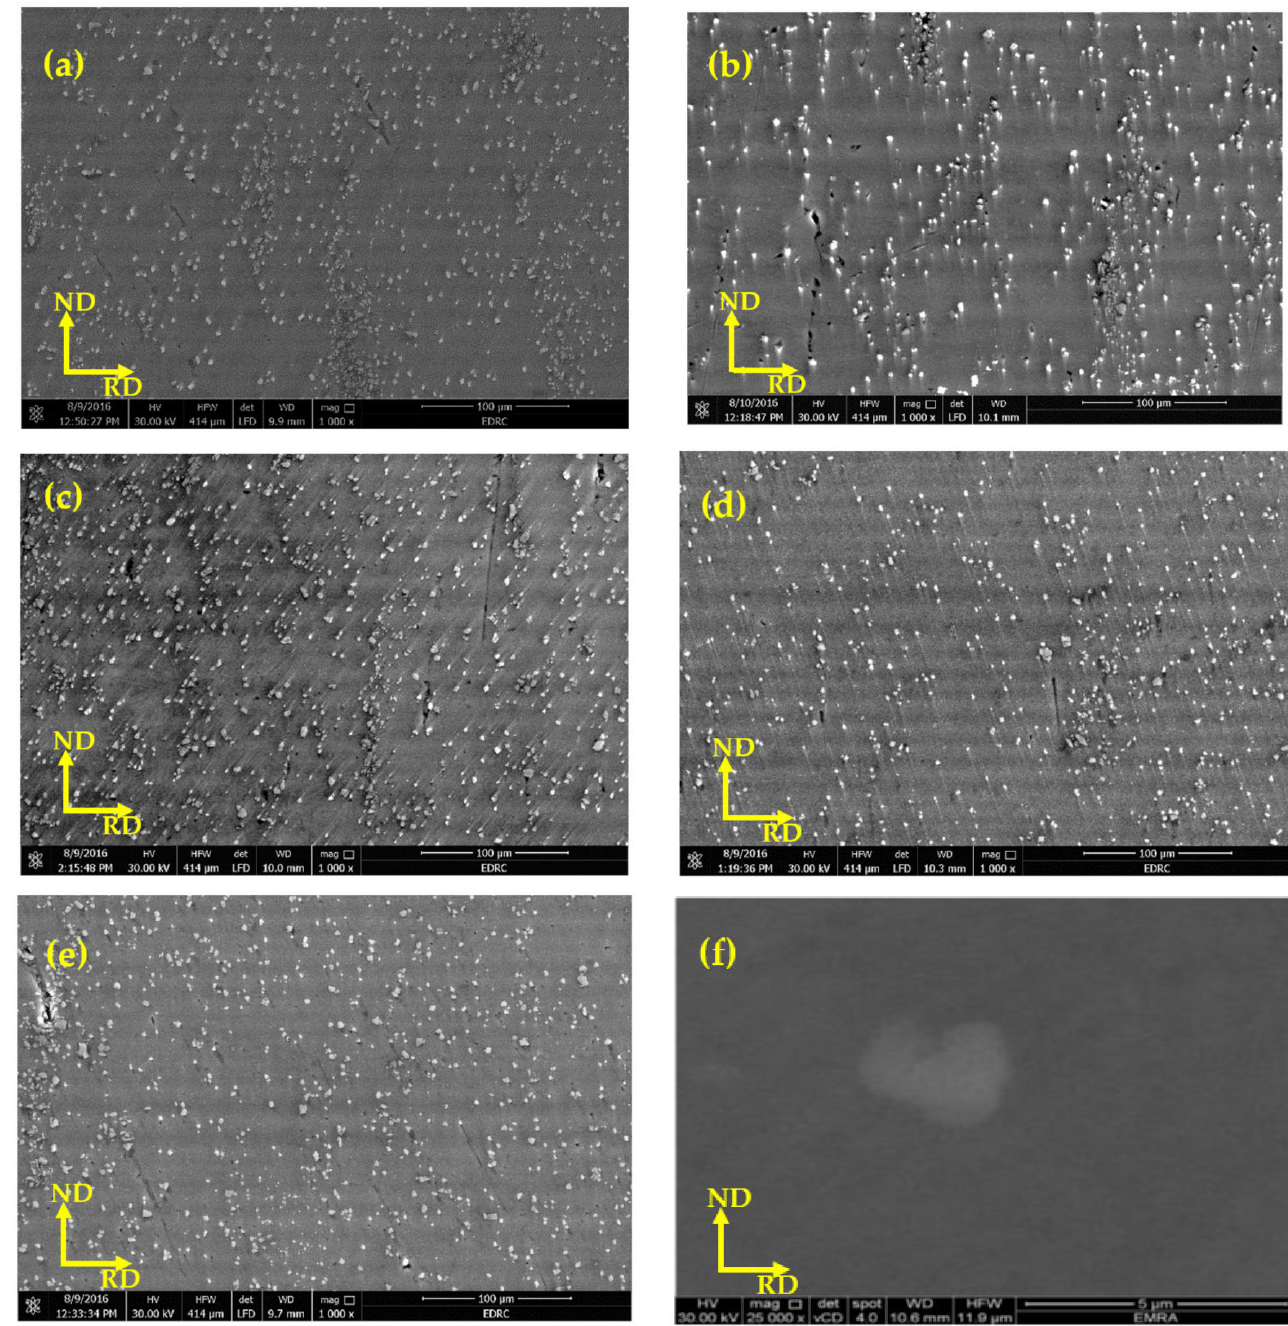
Figure 6. SEM micrographs of Al-4%SiC: ( a ) after one ARB cycle, ( b ) after two ARB cycles, ( c ) after three ARB cycles, ( d ) after four ARB cycles, and ( e , f ) after five ARB